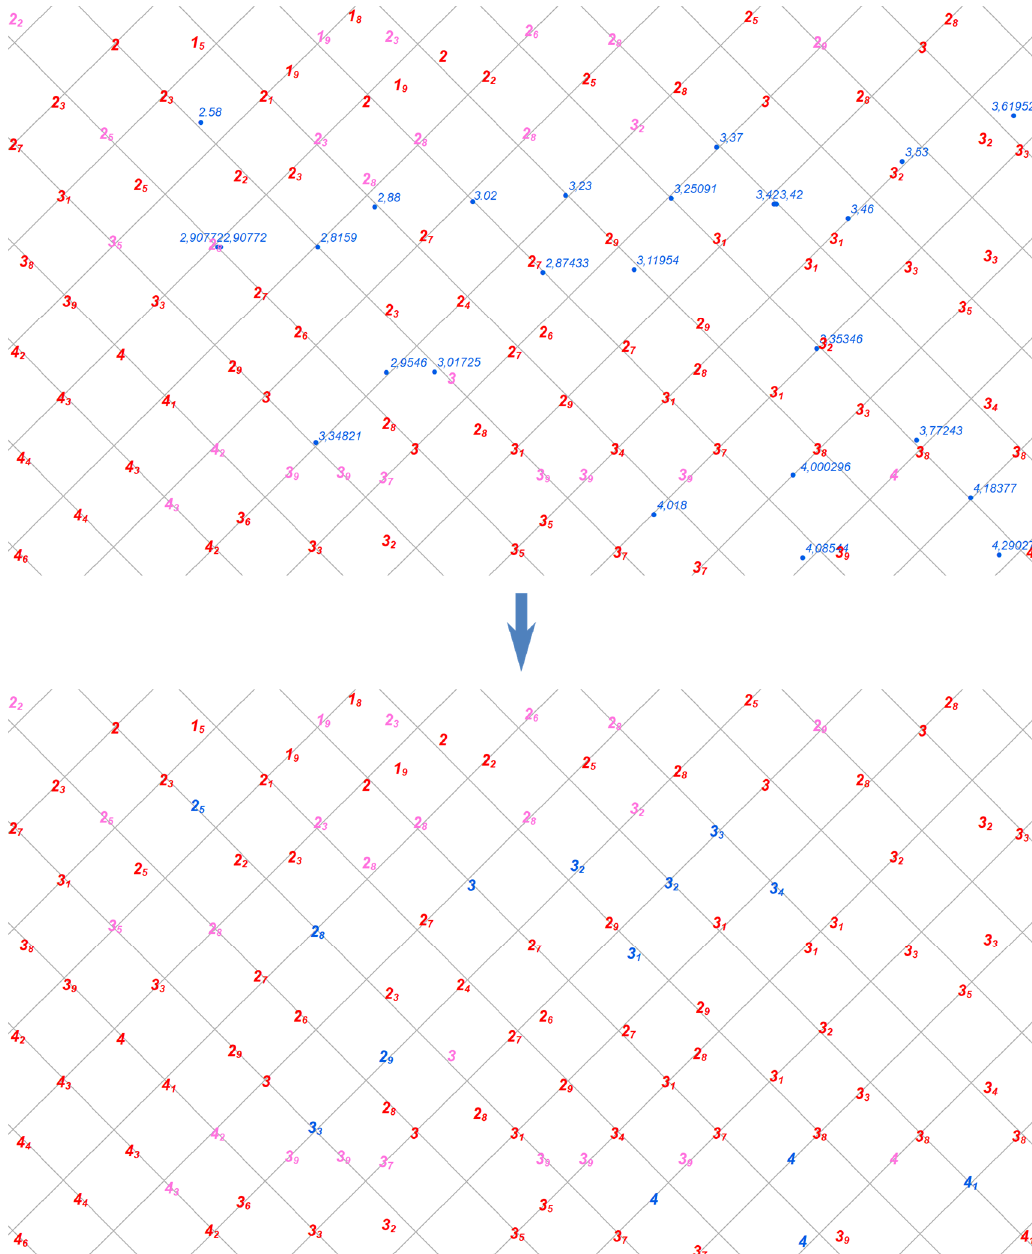
Figure 4. Background soundings selection (blue—Background, pink—Prime deep, red—Prime shoal): (top image) selected soundings based on fill criteria and (bottom image) retained soundings based on distance criteria.